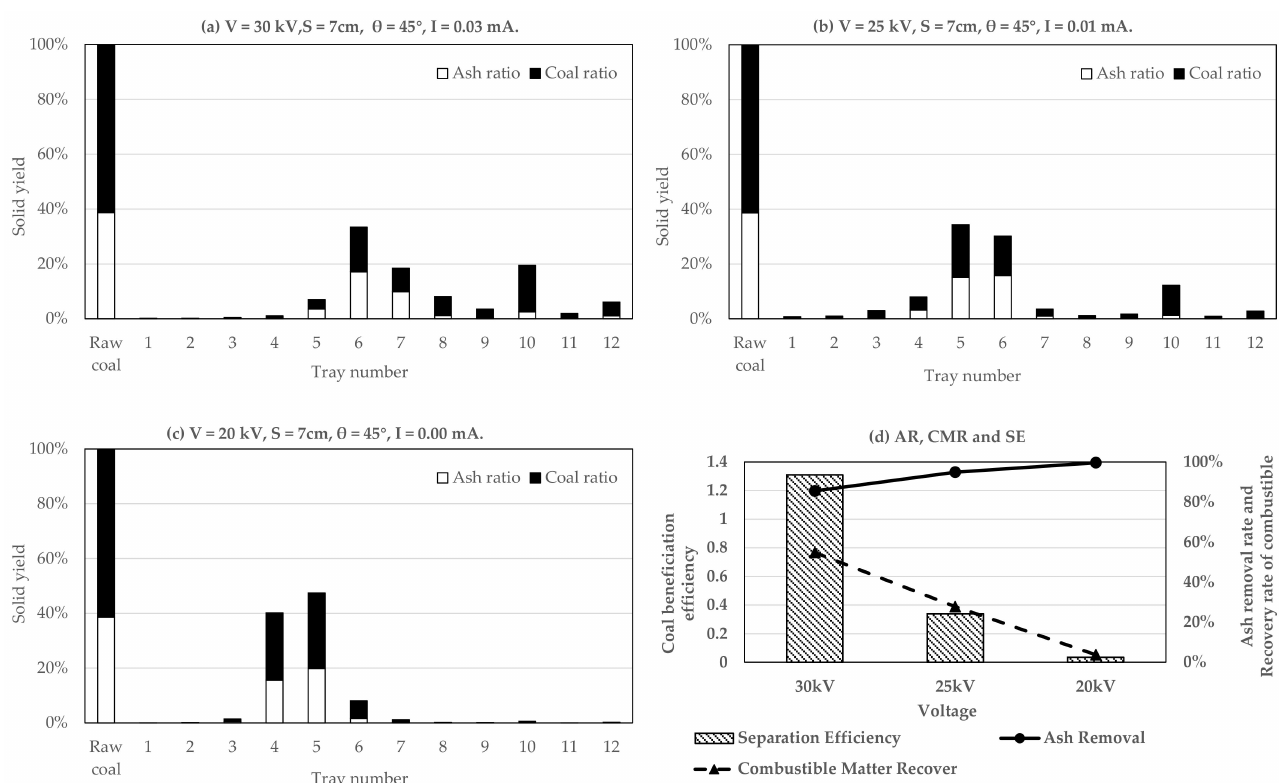
Figure 2. Influence of voltage V on coal beneficiation effect (three experimental conditions ( a – c )): the distance S between the handmade electrodes and the drum is 7 cm, and the angle θ is 45 ◦ ; ( d ): the results for AR, CMR and